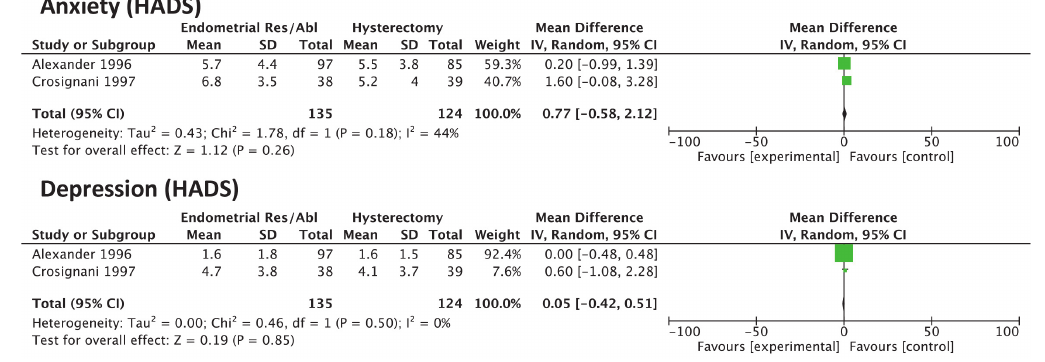
Figure 4. Forest plot for anxiety and depression according to HADS score.